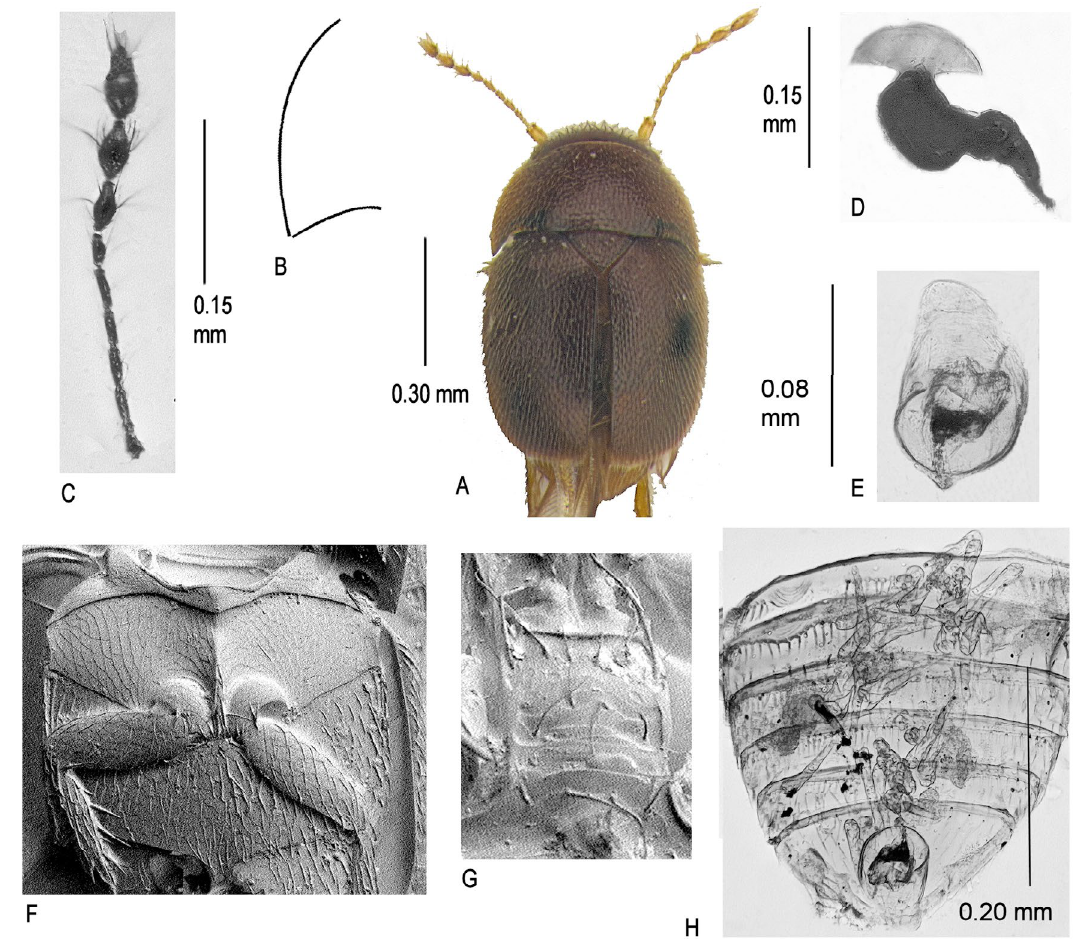
Fig. 24. Storicricha umbella sp. nov. A . Habitus. B . Hind angle of pronotum viewed at 45°. C . Antennomeres III–XI. D . Spermatheca. E . Aedeagus. F . Meso- and metaventra ×340. G . Mentum and submentum ×1300. H . Abdominal